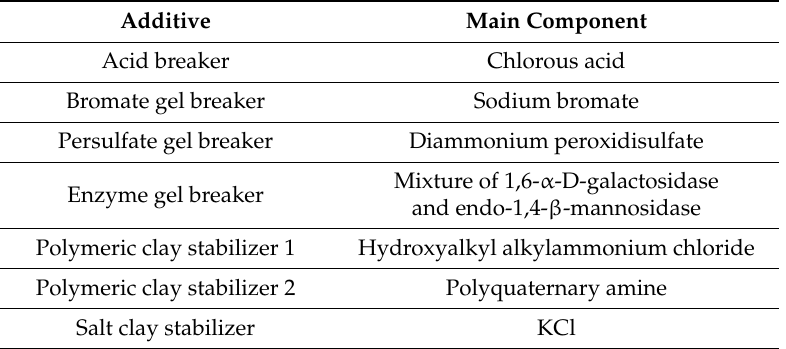
Table 2. Used additives